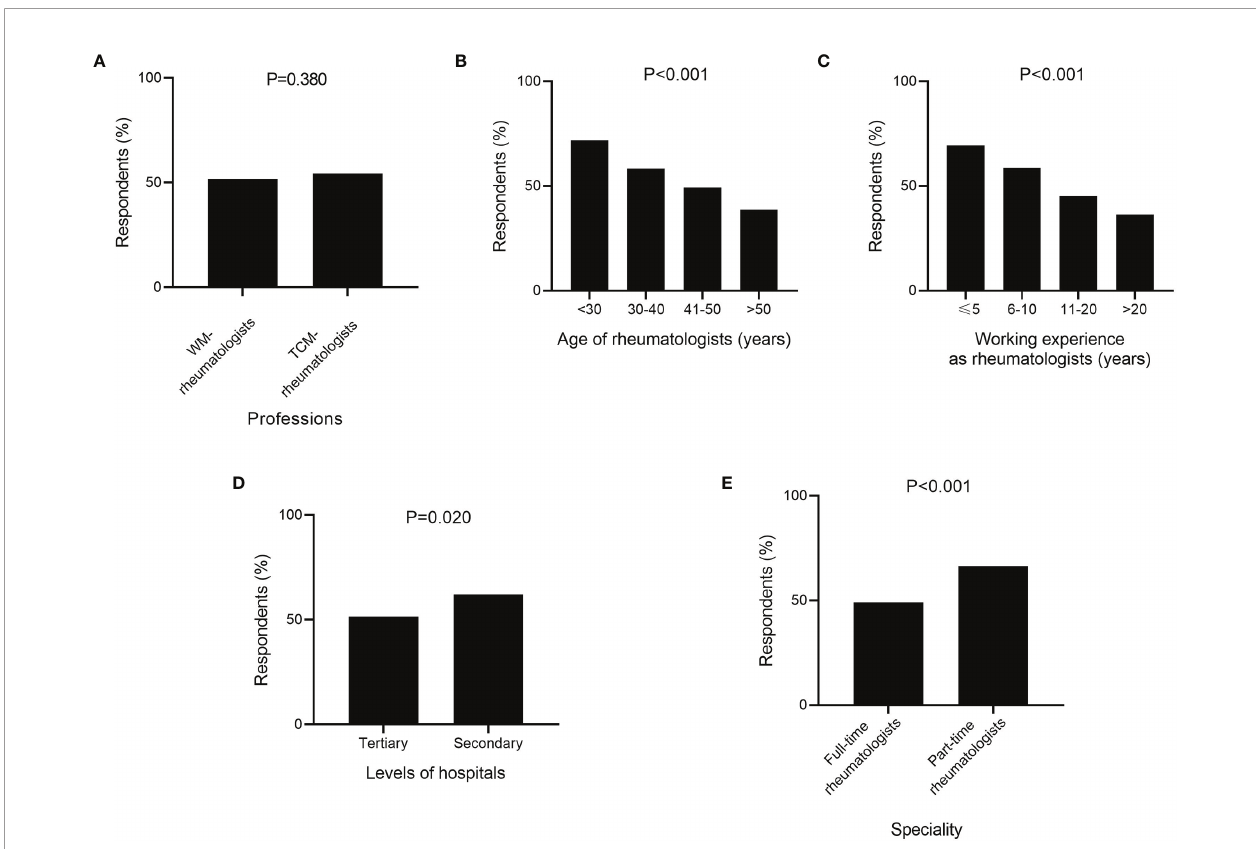
FIGURE 3 | Strati fi ed analysis of respondents with challenges in diagnosing psoriatic arthritis (PsA) by medical training system (A) , age of rheumatologists (B) , working experience as rheumatologists (C) , levels of hospitals (D) , and speciality of respondents (E) . (A) WM, Western Medicine; TCM, Traditional Chinese